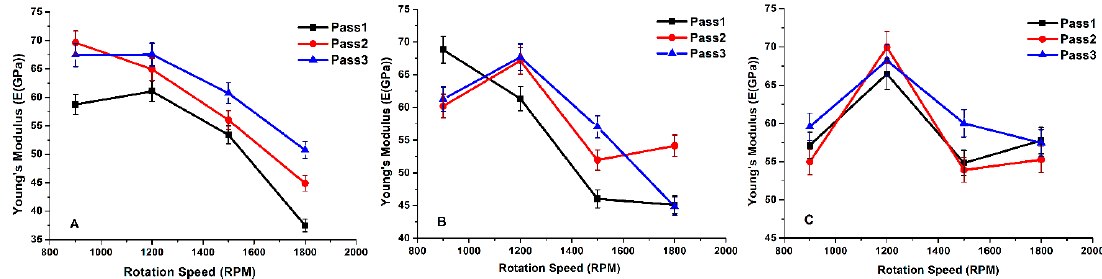
Figure 2. Effect of the number of passes on Young’s Modulus at ( A ) 10 mm/min travel speed; ( B ) 15 mm/min travel speed and ( C ) 20 mm/min travel speed.